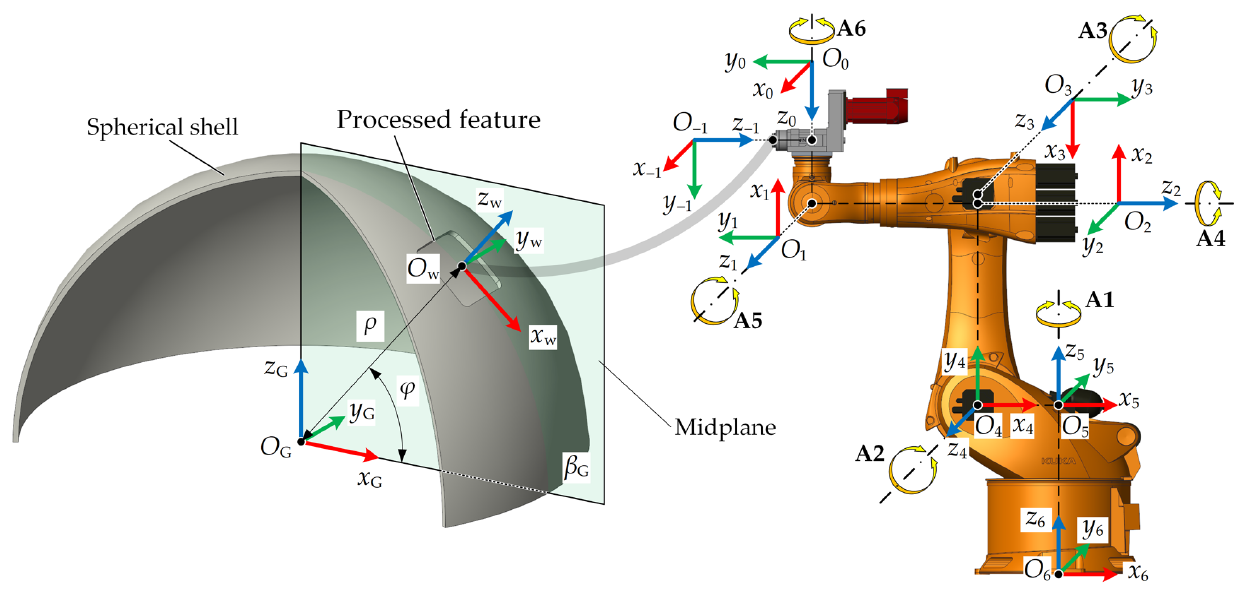
Figure 2. Coordinate systems of the flexible machining system.